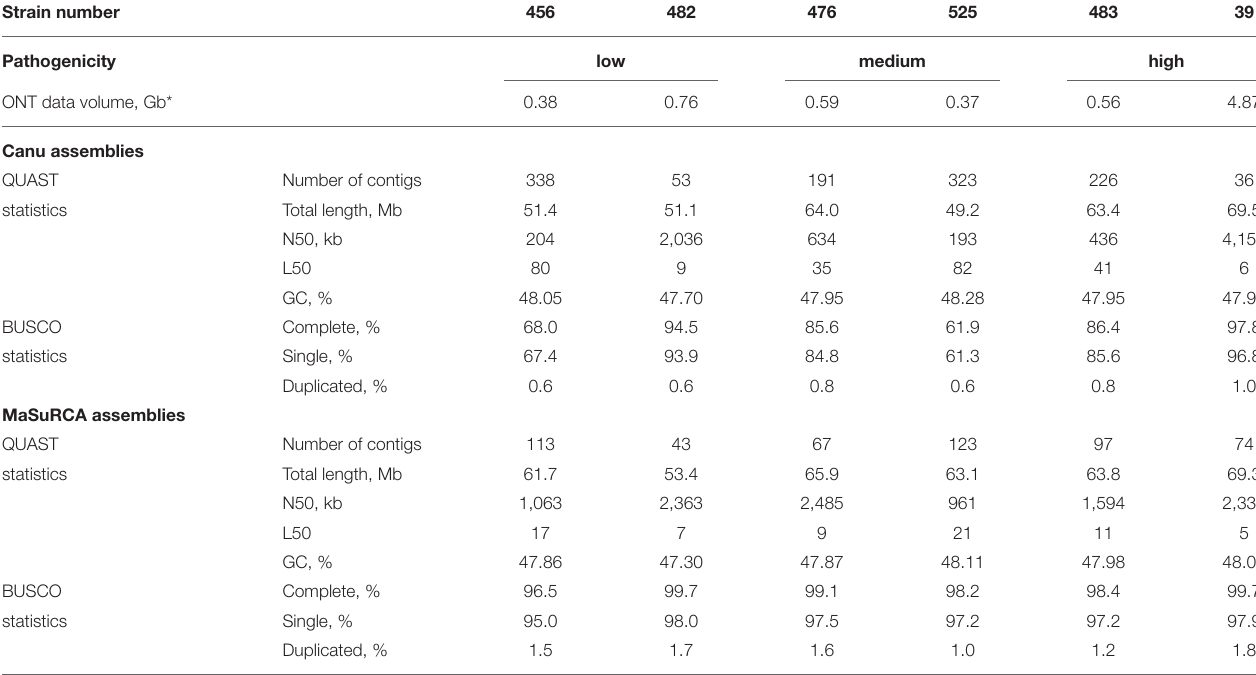
TABLE 1 | QUAST and BUSCO statistics for Canu and MaSuRCA genome assemblies of six F. oxysporum f. sp. lini strains. Strain number Pathogenicity ONT data volume,